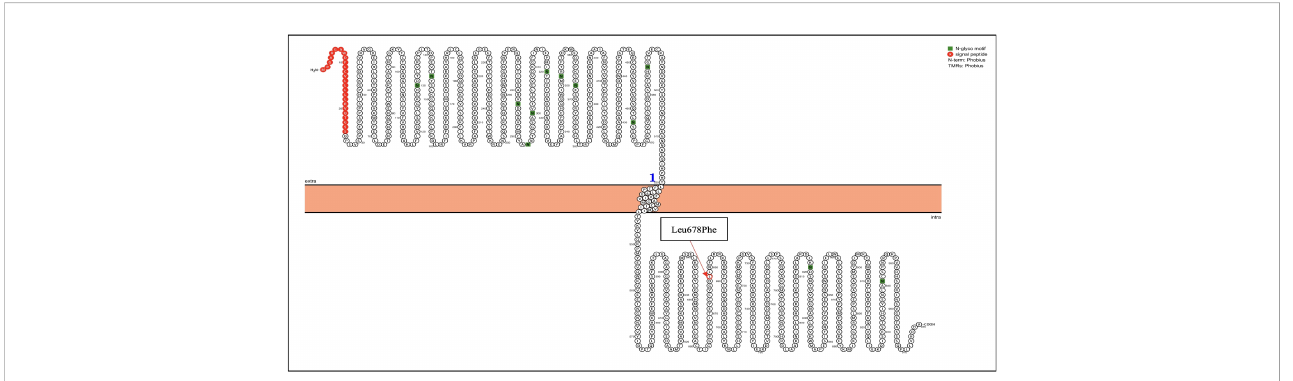
FIGURE 3 KIT genetic mutation identi fi ed in the patient by NGS. Proteins were visualized with Protter (12). The red circle highlights the identi fi ed Leu678Phe mutation in the KIT